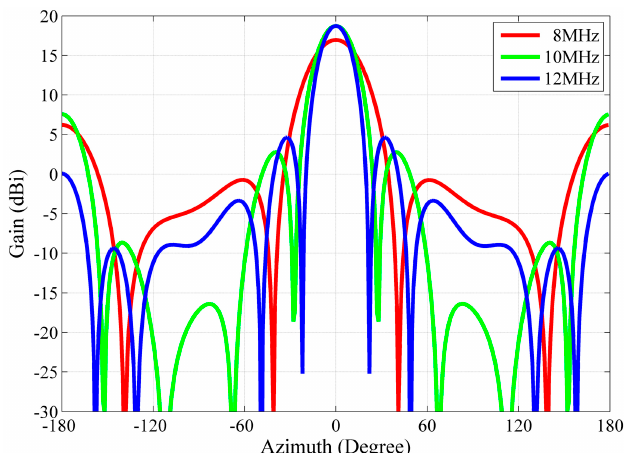
Figure 7. Comparison of the antenna array radiation patterns at 8 MHz (red line), 10 MHz (green line), 12 MHz (blue line) (main lobe vector alignment), where dBi values are with reference to an isotropic gain pattern.